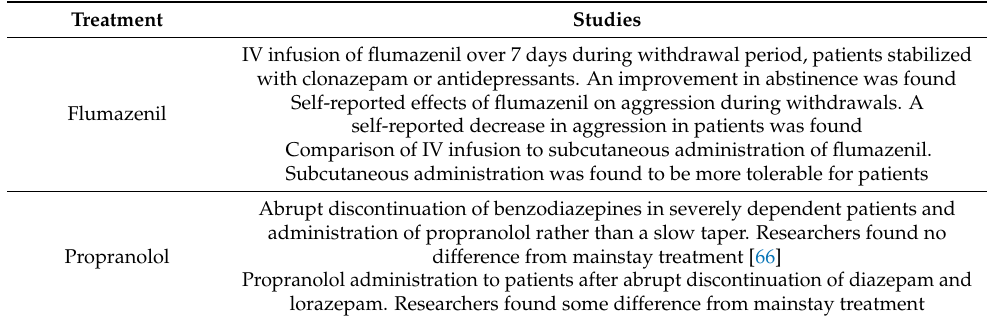
Table 1. Descriptions of studies performed on specific treatments of benzodiazepine dependence and withdrawal